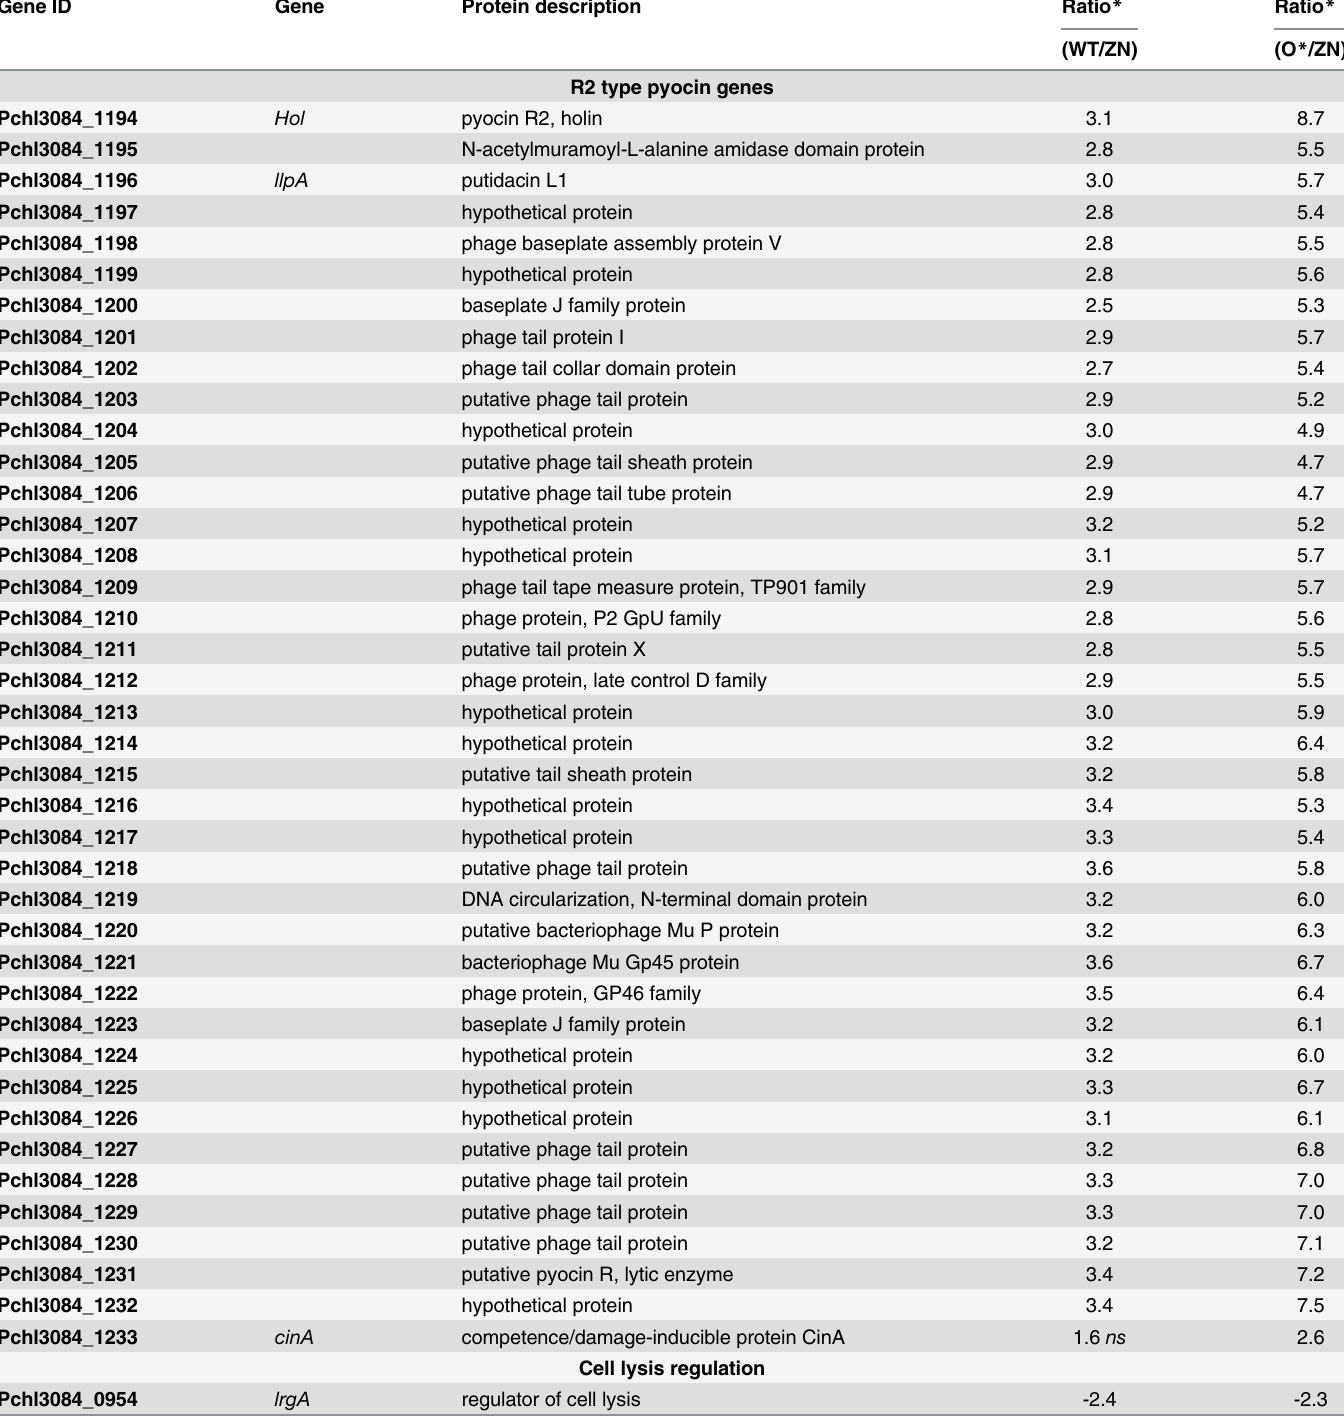
Table 3. Genes annotated as R2 type pyocin genes belonging to a 13 Kb open reading frame spanning a bacteriophage-derived gene cluster from Pchl3084_1194 –